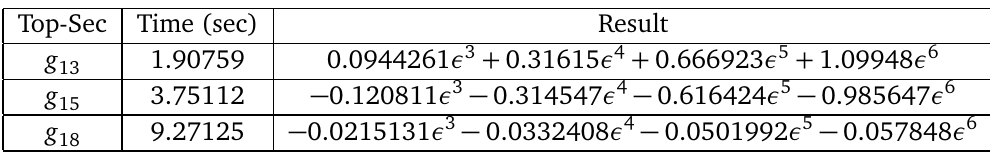
Table 3: Numerical computation of